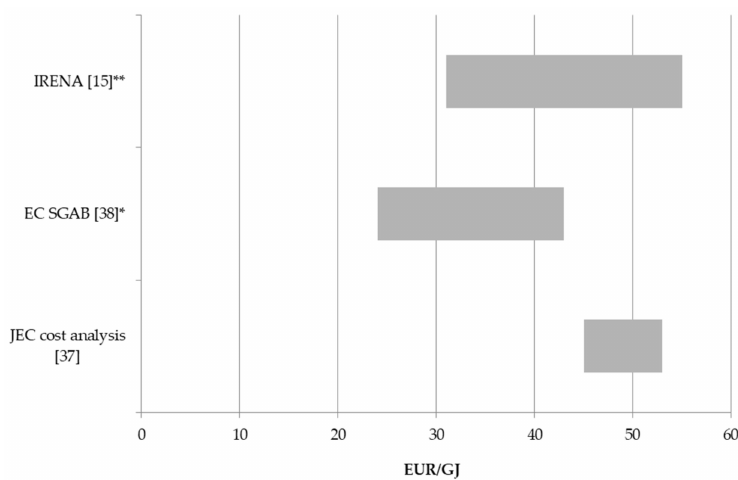
Figure 2. Production costs ranges of cellulosic ethanol from di ff erent studies. * Data extracted from Figure 18 of the report; ** Data from original source (reported for first commercial plants) has been converted from US dollar to Euro assuming 2015 exchange